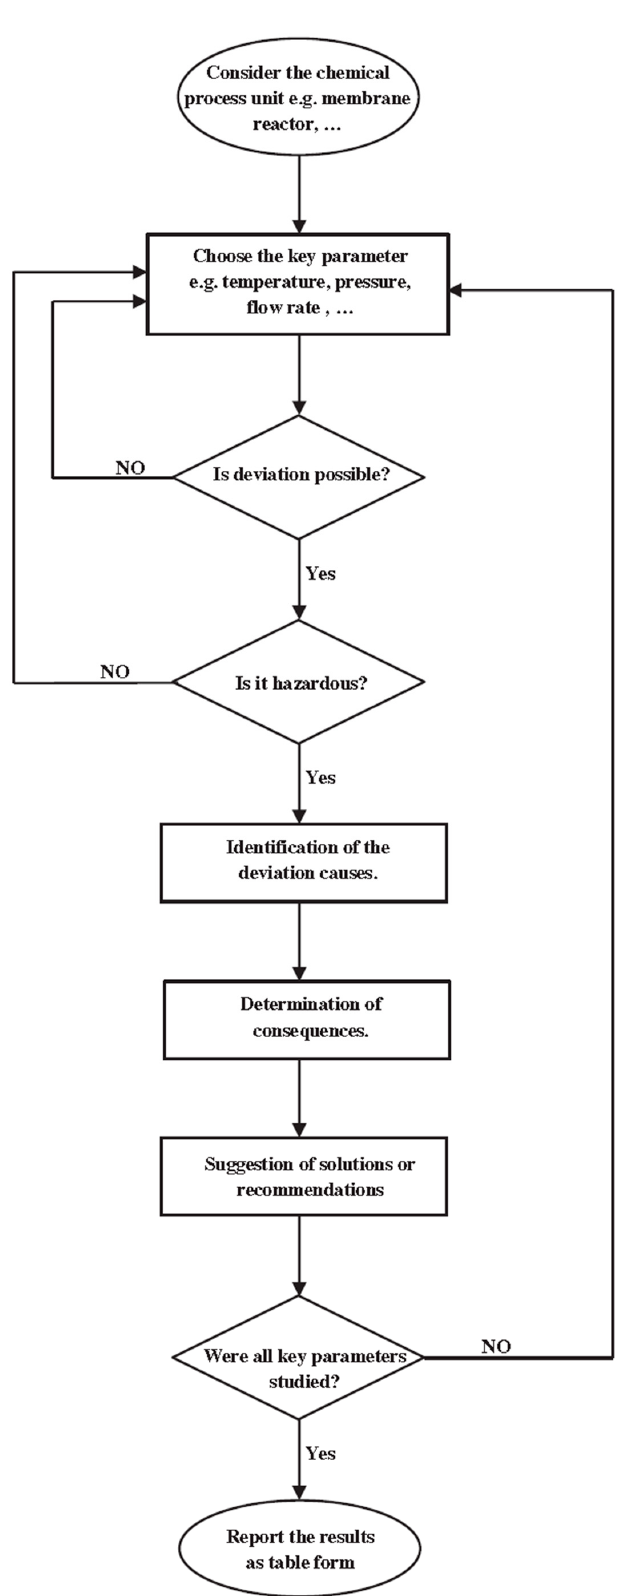
Figure 20. Scheme of the HAZOP approach. With permission of reprint of Elsevier from Ghasezmadeh et al. [65].